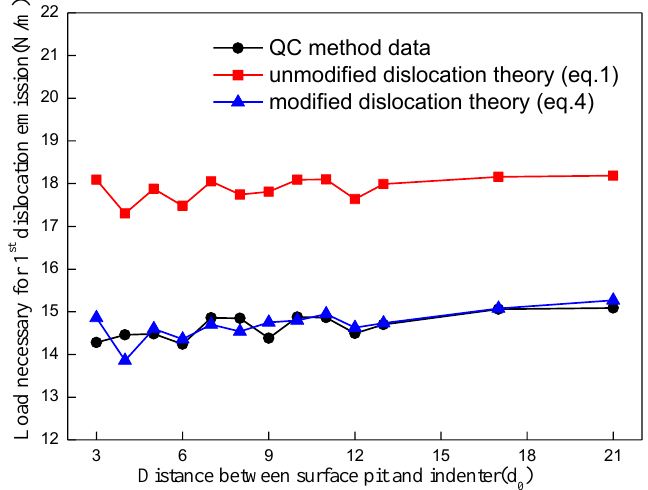
Figure 6. The comparison of the necessary load for elastic-to-plastic transition of Al thin film with various distances between the pit and the indenter calculated by the theoretical formula before and after modification.